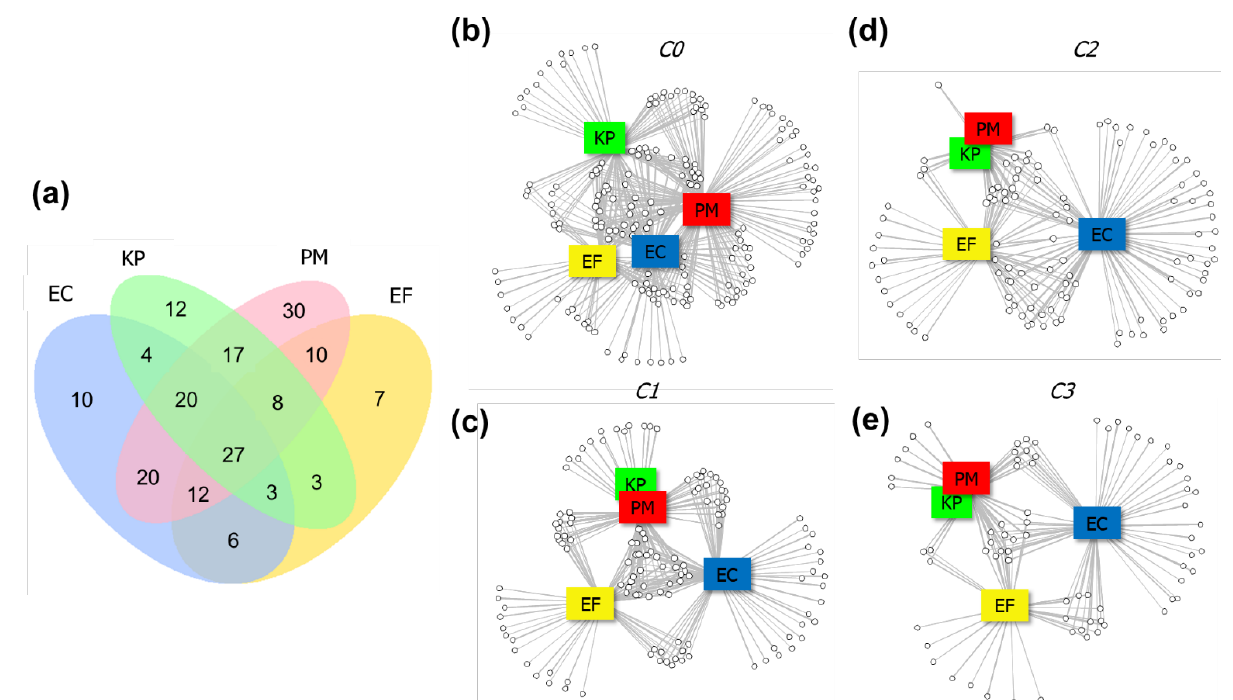
Figure 4. ( a ) Venn diagram displaying the number of compounds coincident between the studied untreated bacterial strains. Networks presenting the connections between the bacterial strains (squares) and respective emitted compounds (circles) for VOC profiles regarding ( b ) untreated cultures and those supplemented with bio-AgNPs at concentrations ( c ) 12.5, ( d ) 25 and ( e ) 50 µg mL −1 . EC = E. coli , EF = E. faecalis , KP = K. pneumoniae , PM = P. mirabilis .